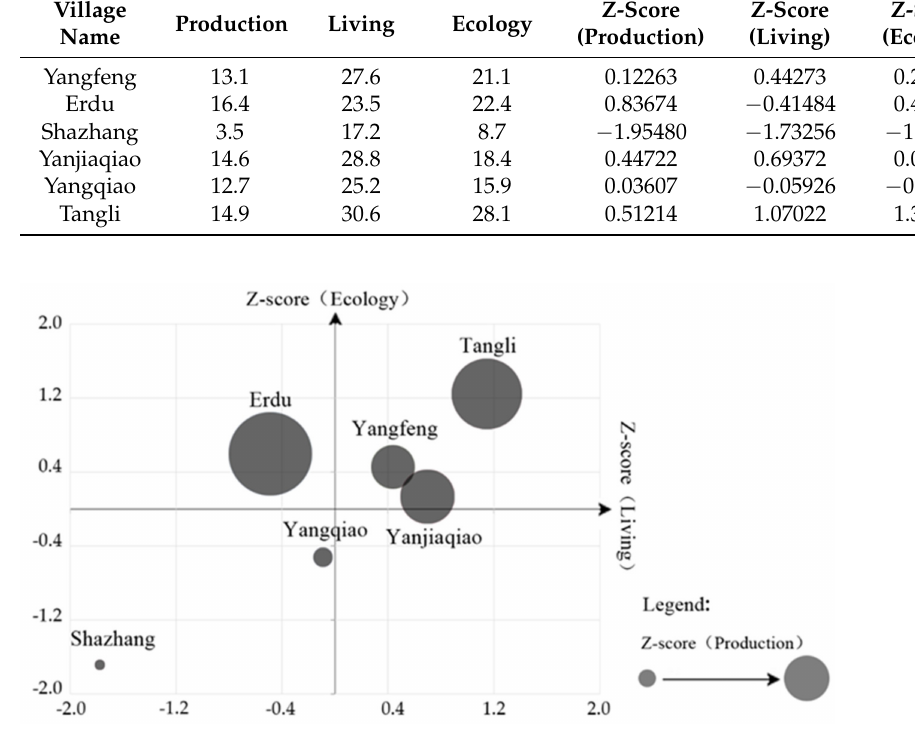
Figure 9. Z-scores of production, living, and ecology after normalization.